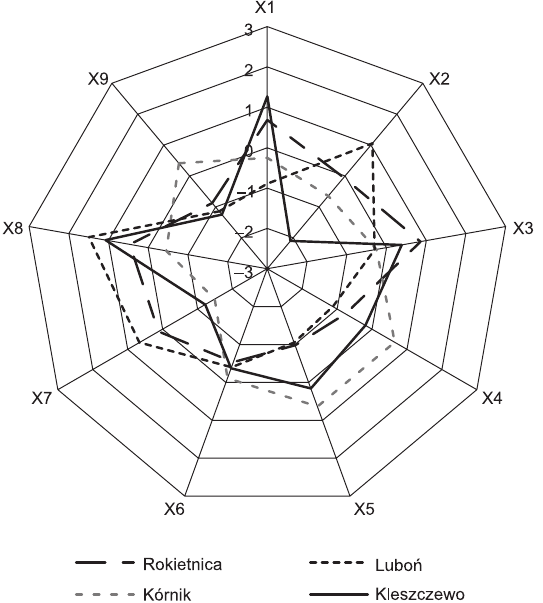
Fig. 4. distribution of the values of normalised indicators in fig. 5. Distribution of the values of normalised indicators in communes with relatively less favourable determinants of communes with relatively unfavourable determinants of the the quality of life as compared with the Poznań agglomer - quality of life as compared with the Poznań agglomeration. ation. Source: own Source: own material.